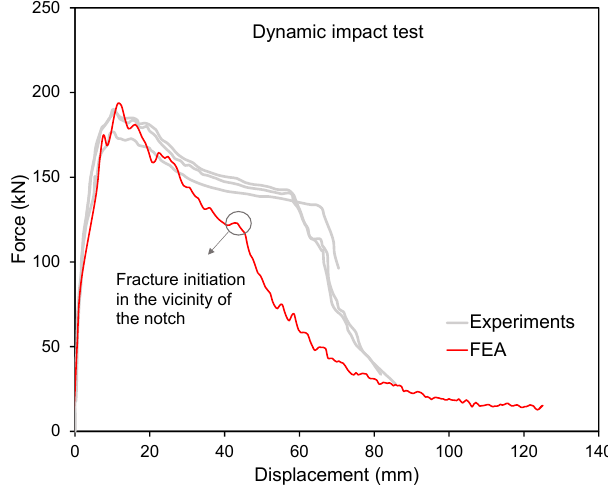
Figure 14. Force-displacement curve obtained using a constant failure strain.